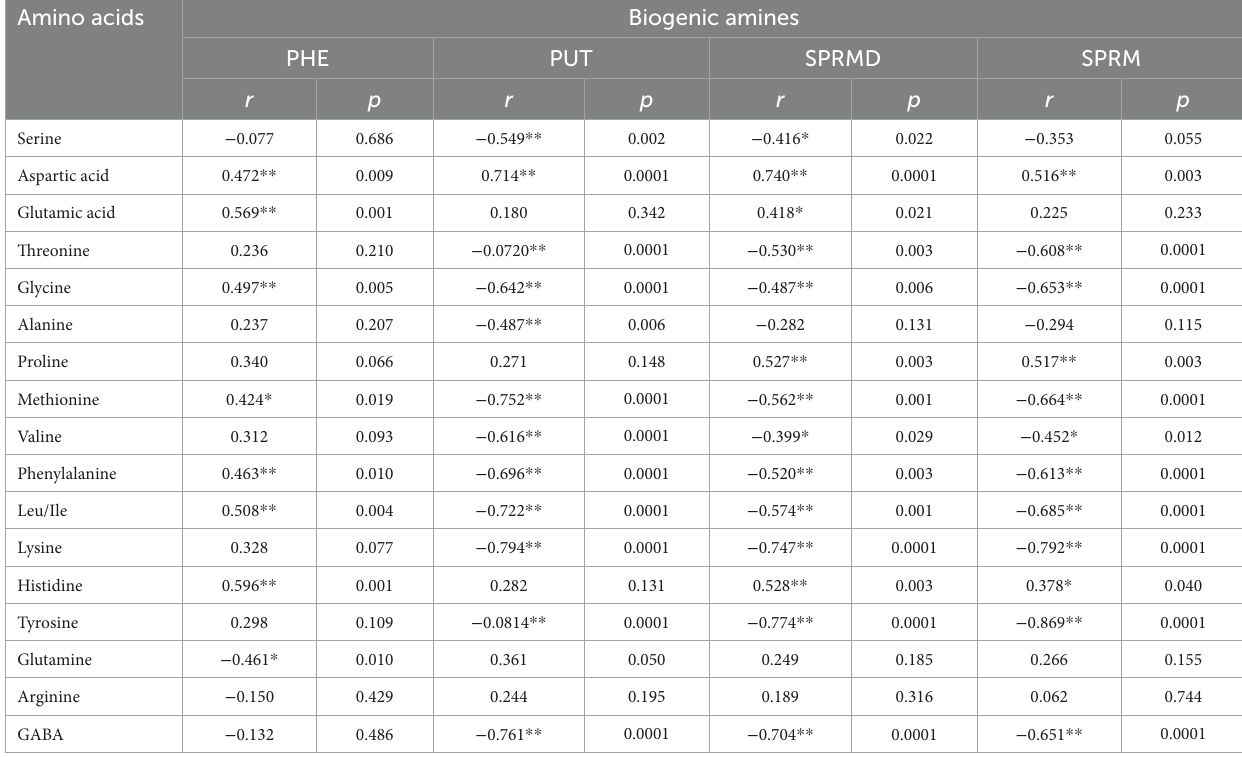
TABLE 3 Pearson correlations between gamma-aminobutyric acid (GABA), free amino acid (FAA) and biogenic amine (BA) concentration in lentil samples. Amino